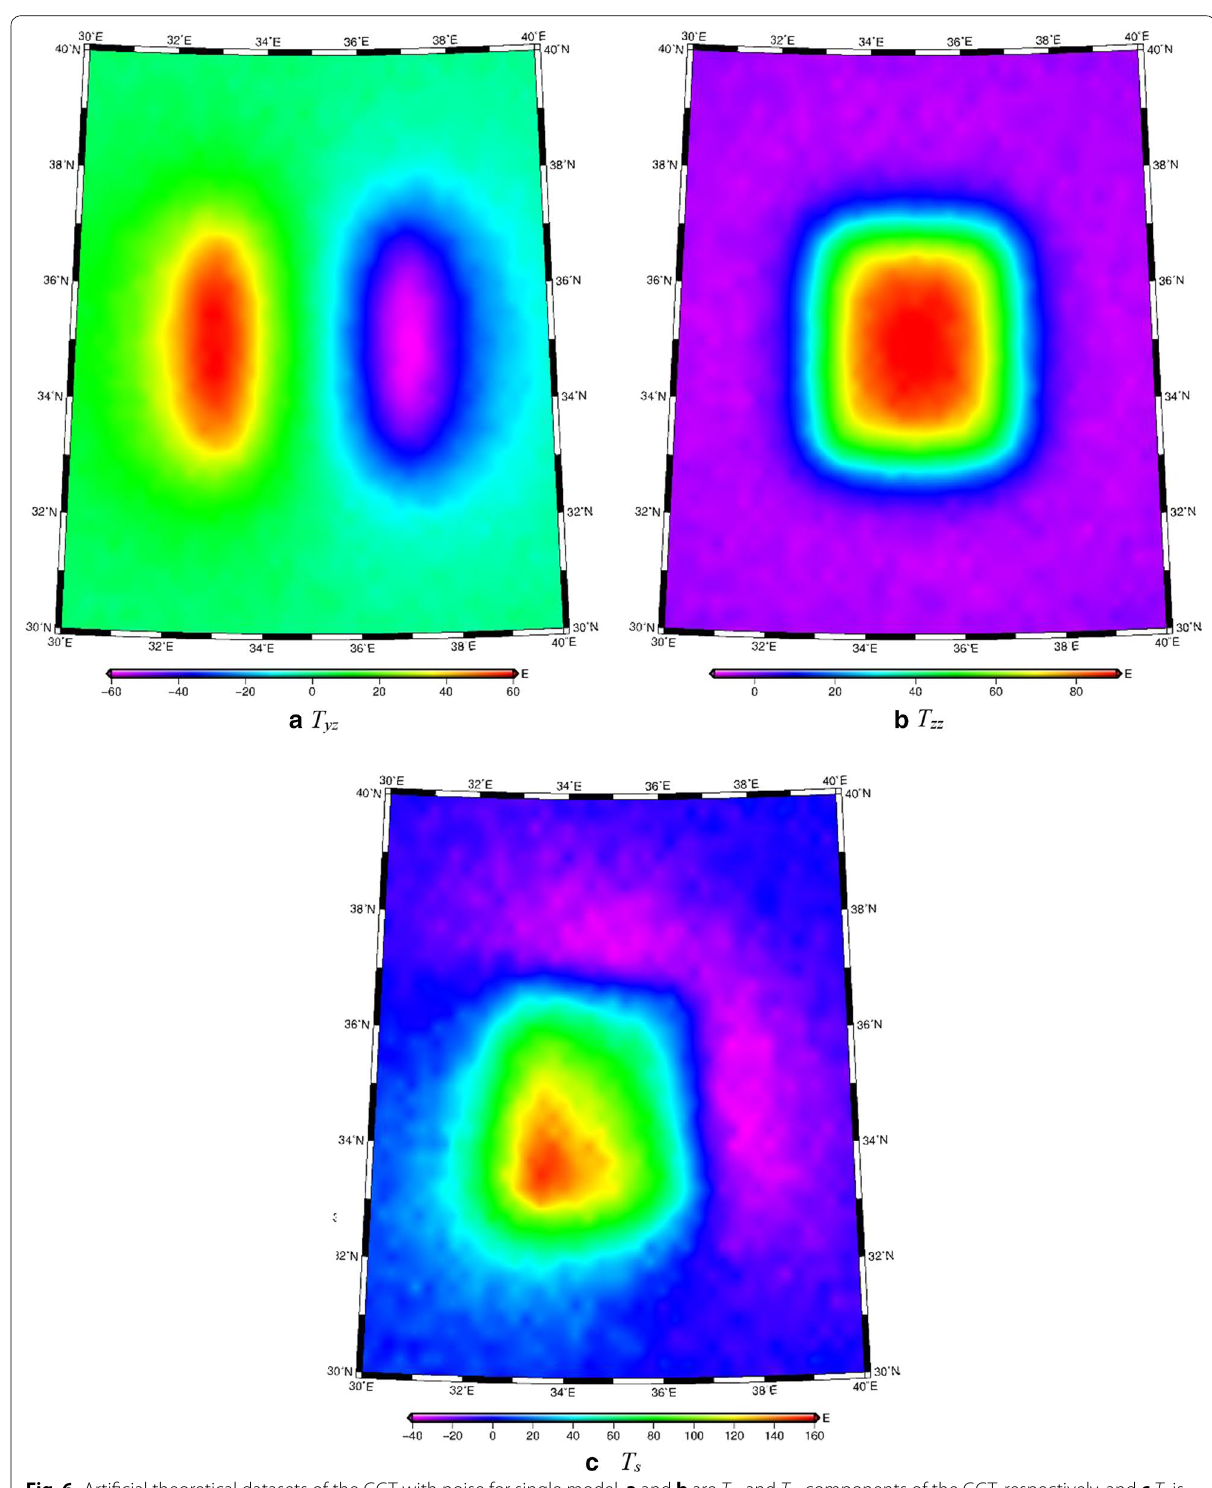
Fig. 6 Artificial theoretical datasets of the GGT with noise for single model, a and b are T yz and T zz components of the GGT, respectively, and c T s is the summation of T xx , T xy , T xz , T yy , T yz and T